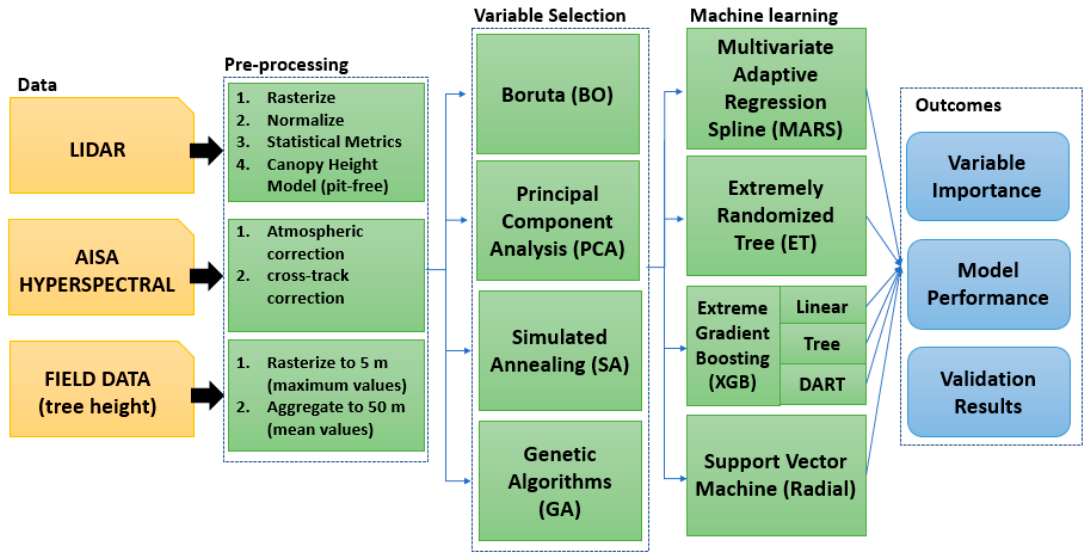
Figure 4. Research workflow.